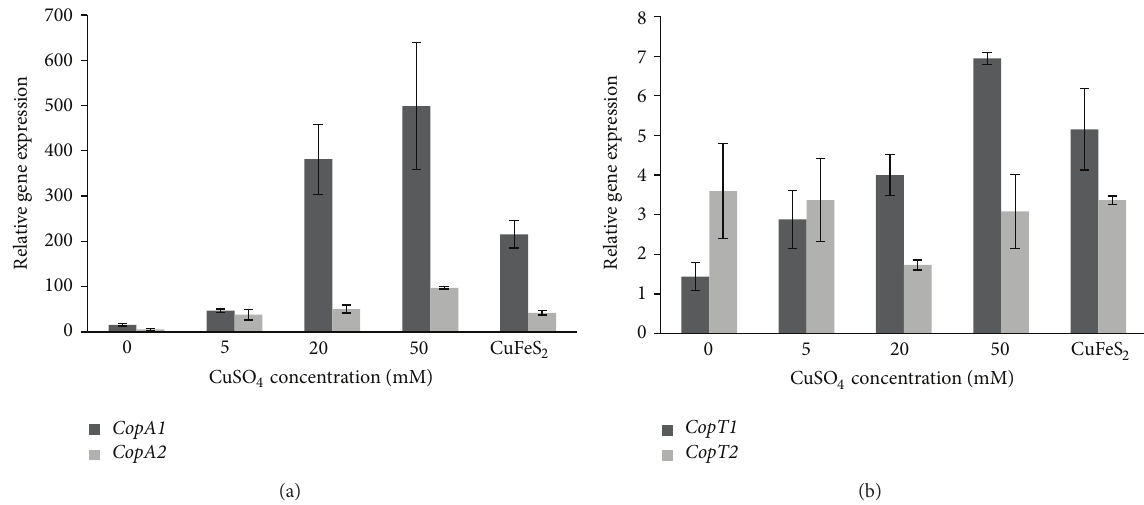
Figure 8: Relative expression levels of S. metallicus genes copA1 and copA2 (a) copT1 and copT2 (b). Expression of S. metallicus cop genes wasassessed by qRT-PCR and normalized against 16S rRNA gene expression in individual cultures. Mean values and standard deviations are from analyses of three independent cultures grown in the presence of 0, 5, 20, 50mM Cu or in 1% of a chalcopyrite ore (CuFeS 2 )